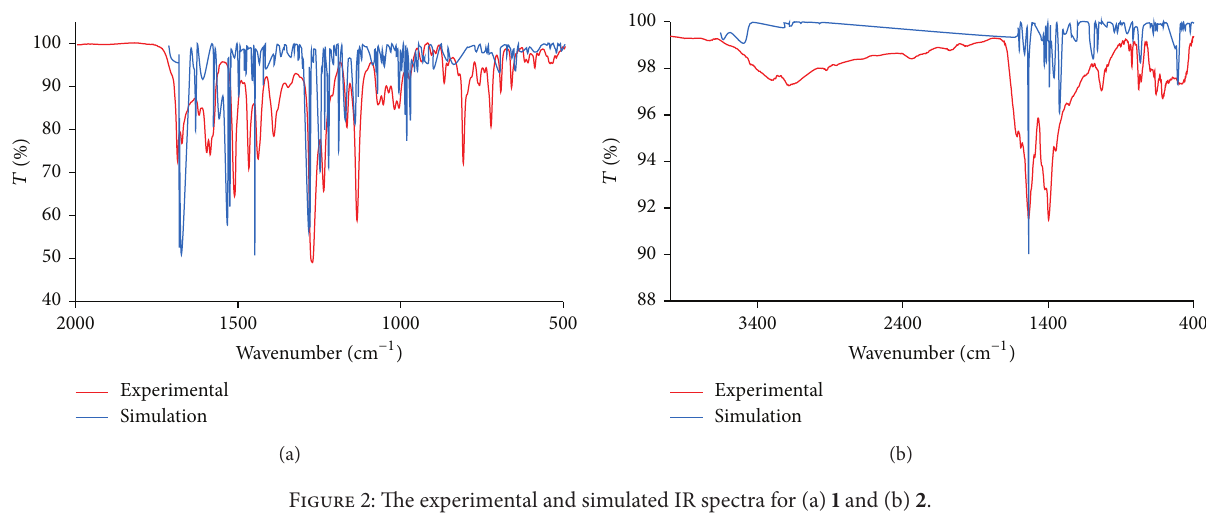
Figure 2: The experimental and simulated IR spectra for (a) 1 and (b) 2 .